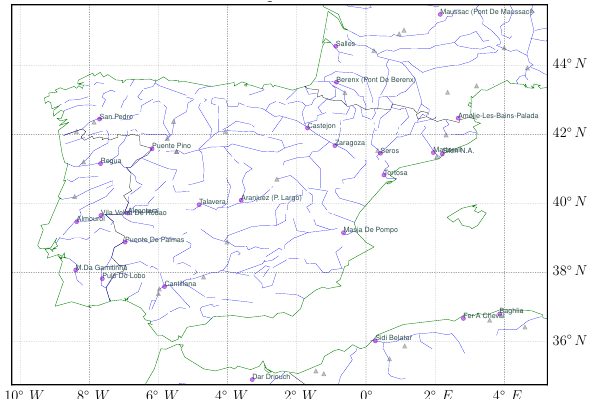
Figure 2. The river network (blue lines) and the GRDC stations (solid dots represent the 27 qualified stations and the gray triangles represent unqualified stations) over the study